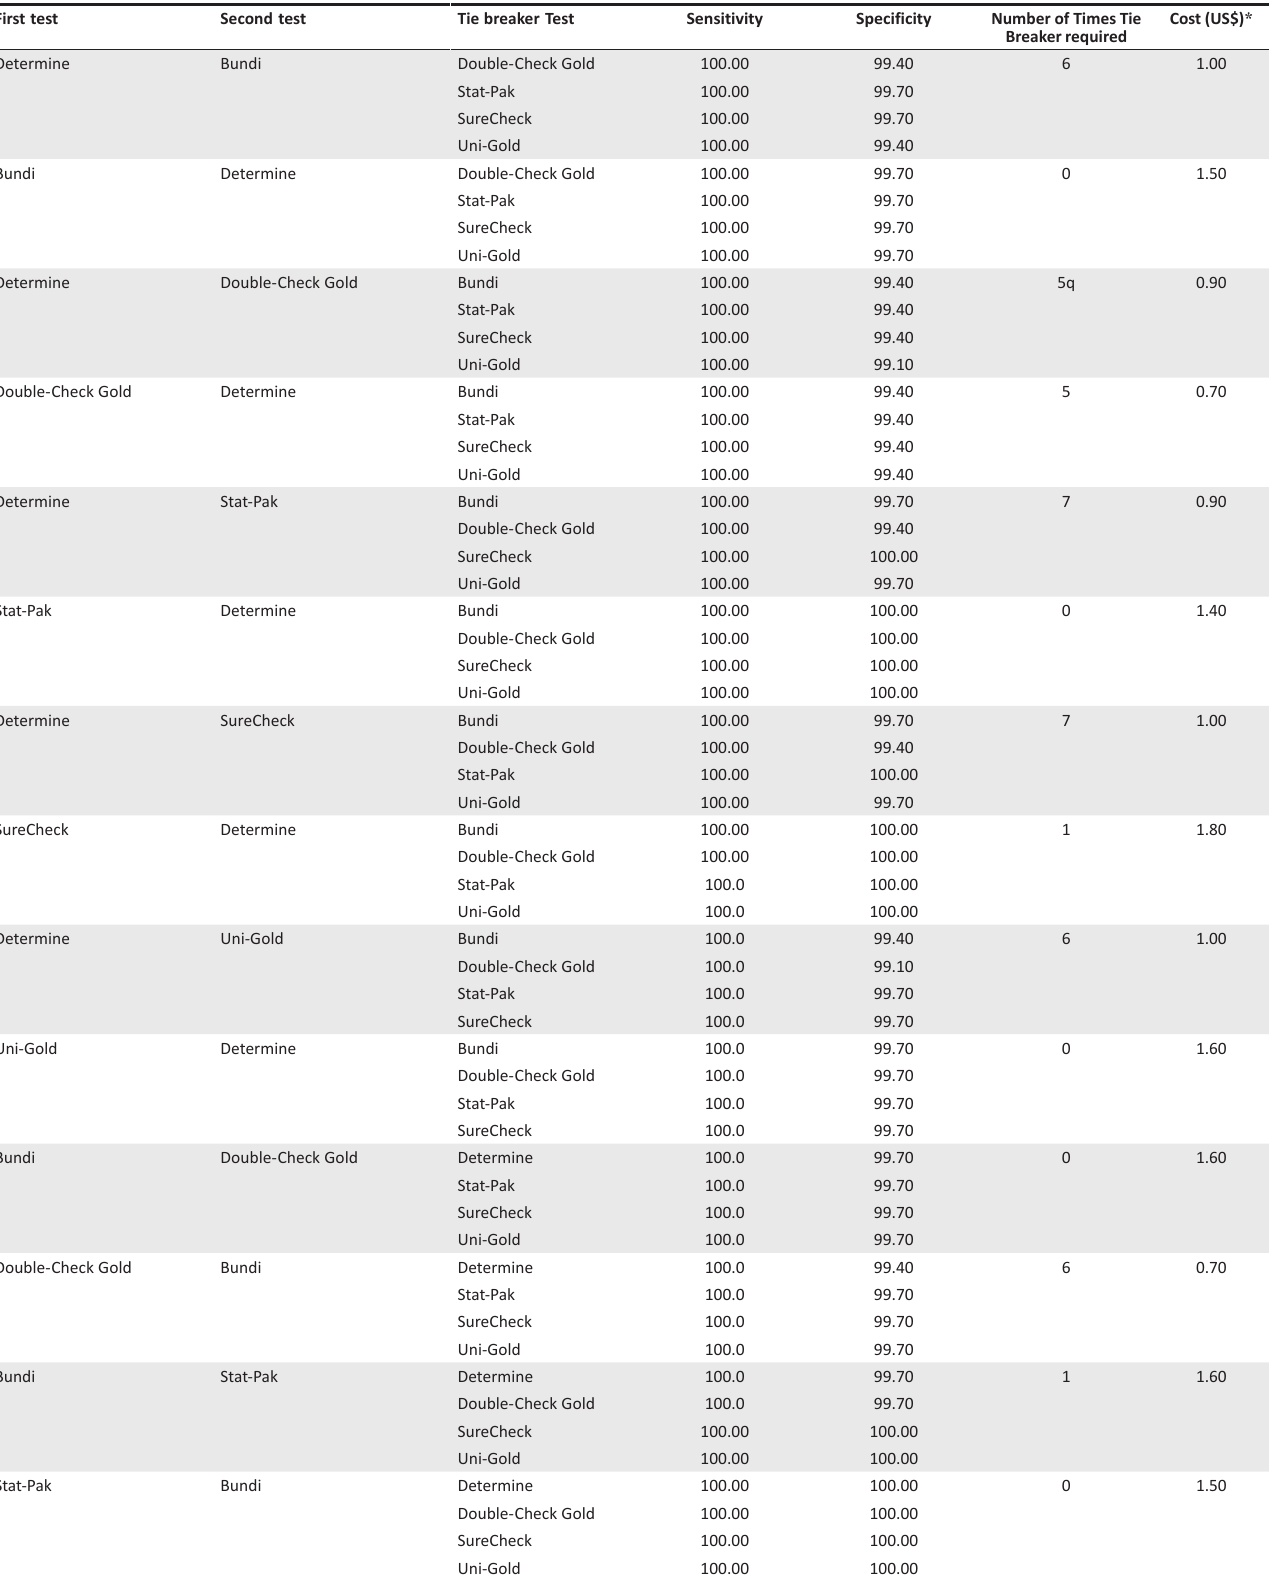
Serial Algorithms: * , Assuming a prevalence of 10.0 % attesting